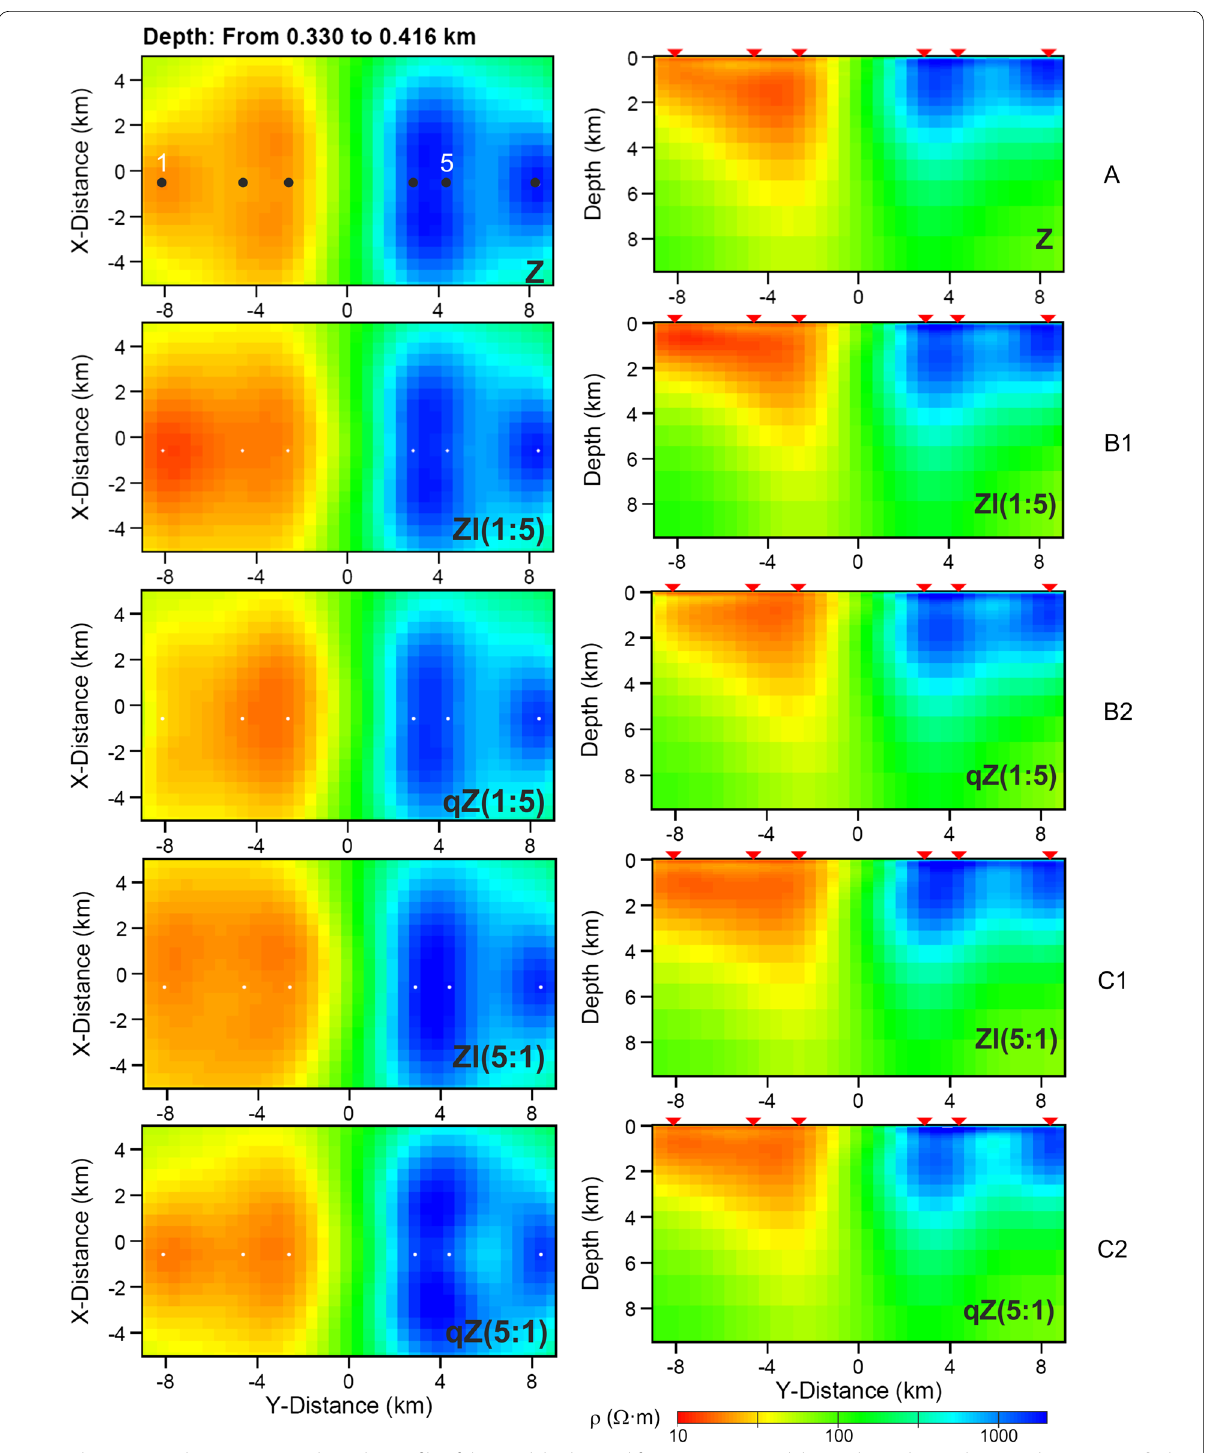
Fig. 3 Plan views and cross sections along the profile of the models obtained from inverting Model 1 synthetic data: a the impedance Z (top), b the interstation impedance ZI ( E :1; B :5) and quasi‑impedance qZ ( E :1; B :5) (middle), as well as c ZI ( E :5; B :1) and qZ ( E :5; B :1)